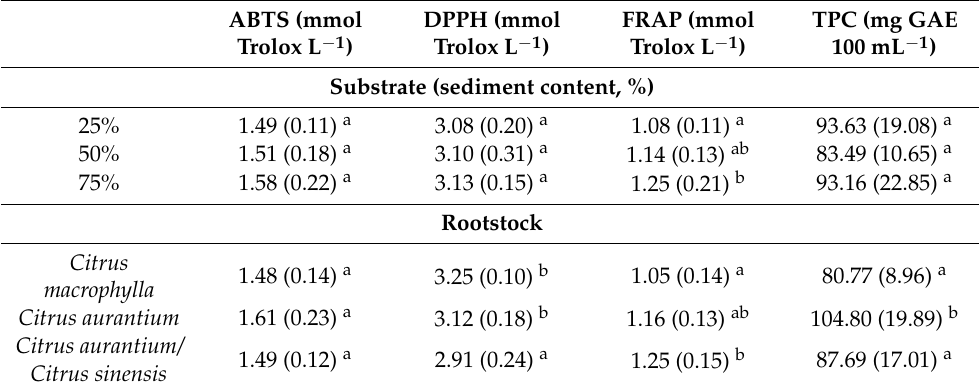
Table 6. Total phenolic content (TPC, mg GAE 100 mL − 1 ) and antioxidant capacity variations measured according to ABTS, DPPH, and FRAP (mmol Trolox L − 1 ) for ‘Verna’ lemons obtained on different rootstocks and substrates. The values represented are the mean with its standard deviation in